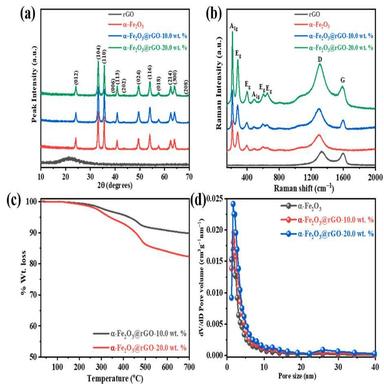
(a) XRD, and (b) Raman plots of rGO, α-Fe2O3, and α-Fe2O3@rGO core@shell nanocubes, (c) TGA plot of α-Fe2O3@rGO core@shell nanocubes, and (d) BJH plot of α-Fe2O3, and α-Fe2O3@rGO core@shell nanocubes.